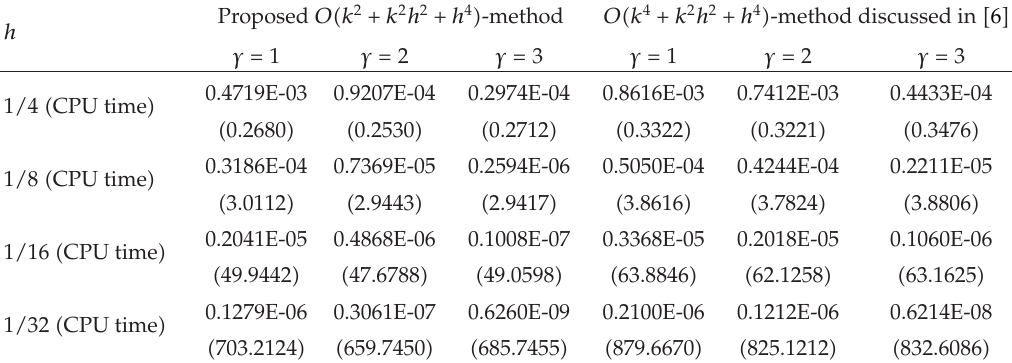
Table 3: Example 6.3: the maximum absolute errors (cid:4) with CPU time (cid:5)